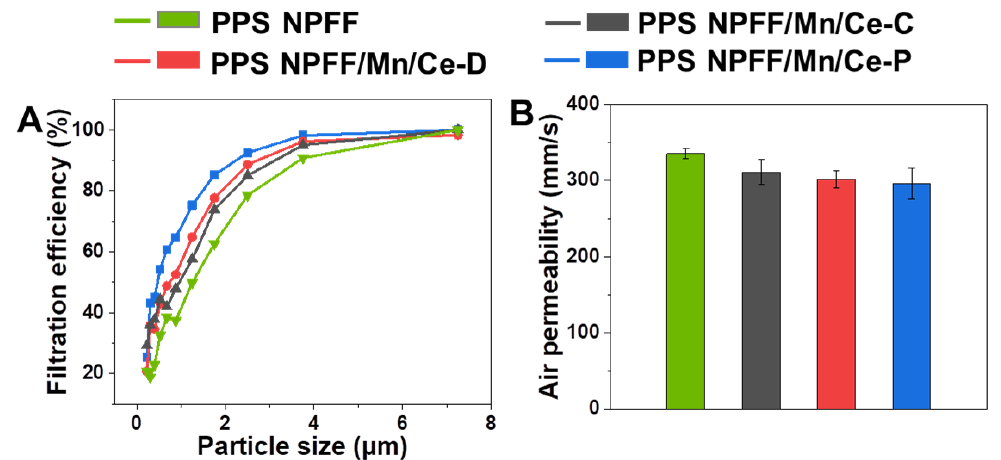
Figure 8. ( A ) Filtration efficiency and ( B ) air permeability of the original PPS NPFF and the three different Mn/Ce oxides decorated PPS NPFF.